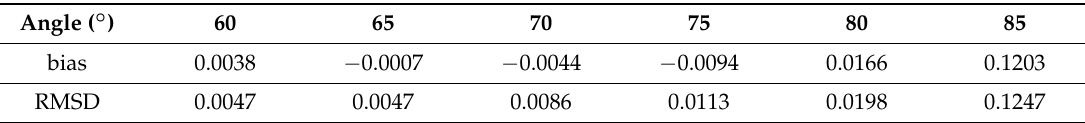
Table 2. The bias and RMSD values associated with the simulated sea surface emissivity spectra with respect to in situ measurements.